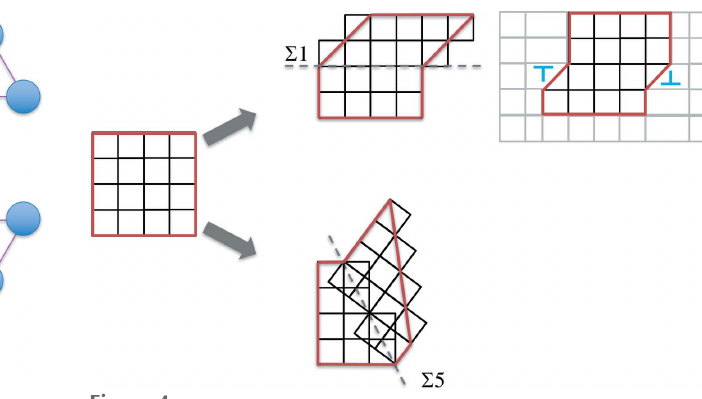
Figure 3 A schematic illustration of the graph homomorphism G ! G H . ( a ) G and ( b ) G H .